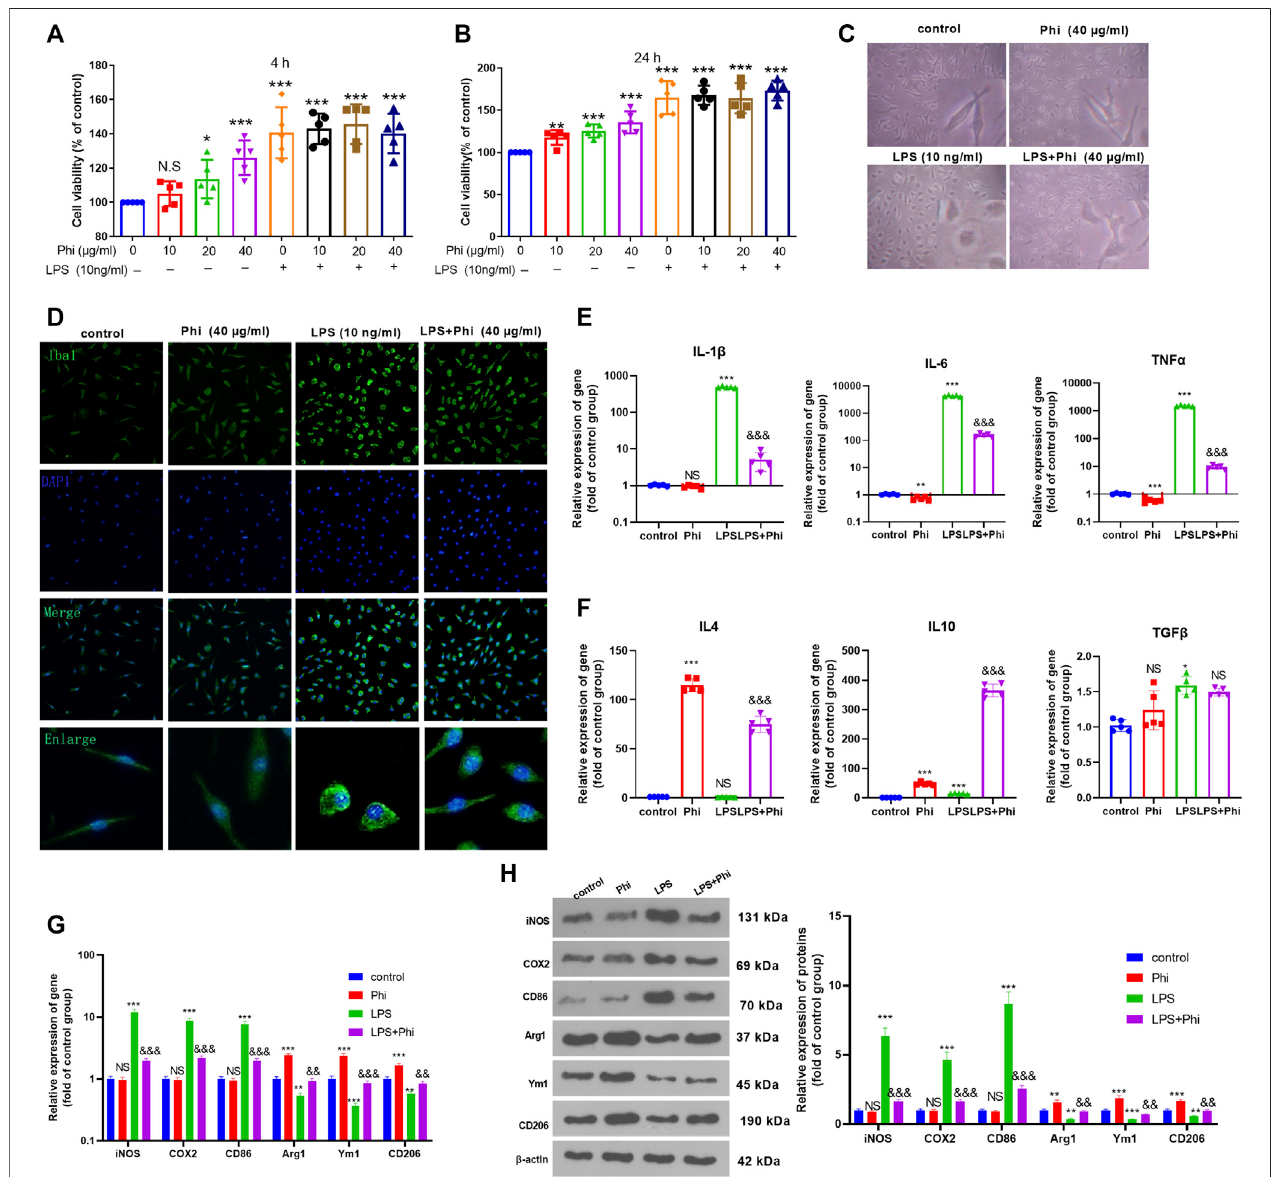
FIGURE1| EffectsofPhiontheviabilityandmorphologyofLPS-inducedmicroglia. (A , B) PrimarymicrogliaweretreatedwithLPS(10 ng/ml)andPhi(rangingfrom 10 to 40 μ g/ml), or their combinations for 4 or 24 h. Then the viability of primary microglia was detected by the CCK-8 method. (C) Primary microglia were treated with LPS(10 ng/ml)and/orPhi(40 μ g/ml)for4 h.ThemorphologicalchangesofmicrogliawererecordedusingalightOlympusmicroscope. (D) Cellularimmuno fl uorescence wasconductedtoevaluatethemicroglialactivation(labeledbyIba1). (E , F) RT-PCRwasconductedtomeasurethe “ M1 ” markersofmicroglia,includingIL-1 β ,IL-6, and TNF α , and “ M2 ” markers, including IL-4, IL-10, and TGF- β . (G , H) RT-PCR or Western blot was conducted to detect the mRNA or protein levels of iNOS, COX2, CD86, Arg1, Ym1, and CD206in microglia. The values are expressed as mean ± SD: NS p > 0.05, * p < 0.05, ** p < 0.01, *** p < 0.001 vs. the control group; NS p > 0.05, && p < 0.01, &&& p < 0.001 vs. the LPS group. n (cid:1)